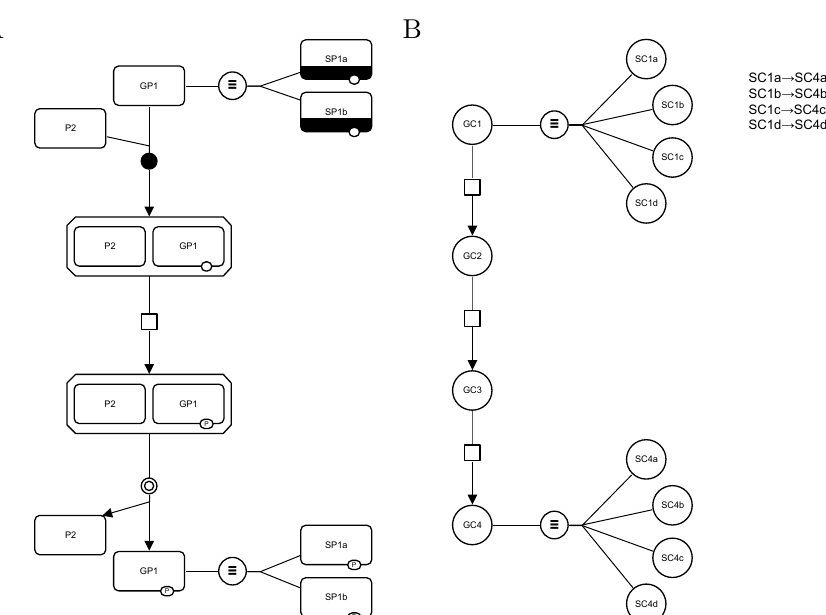
Figure B.5: An example of misuse of the equivalence operator in an abstract pathway involv- ing simple chemicals . A. Correct use. The use of the equivalence operator respects the third rule, because the pathway involves macromolecules , that are stateful EPNs . B. Misuse. The use of the equivalence operator does not respect the third rule, because the pathway involves simple chemicals , that are stateless EPNs